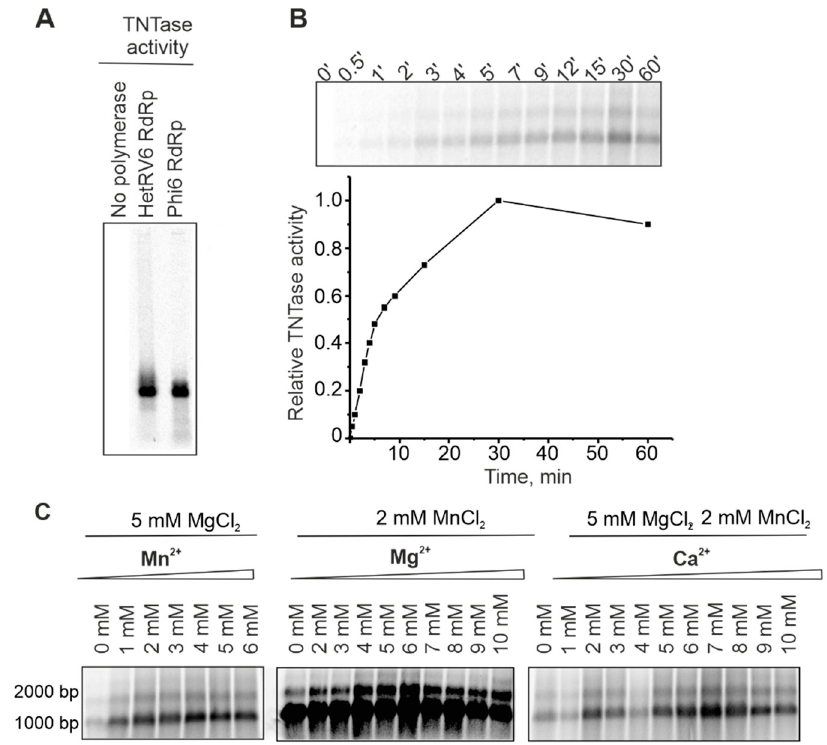
Figure 7. TNTase activity of HetRV6 RdRp. ( A ) ∆ s + ssRNA was used as a template in the TNTase assays catalyzed either by phi6 RdRp or HetRV6 RdRp. Autoradiogram of the reaction products after agarose gel electrophoresis shows label incorporation from [ α - 33 P]-UTP. ( B ) A time course of the TNTase activity on the viral HetRV6 RNA1 + . Quantitation of the labelled RNA product is shown below the autoradiogram of the gel. ( C ) Influence of divalent cations on TNTase activity. Viral HetRV6 RNA1 + was used as a template and UTP as a substrate (no other NTPs were included).